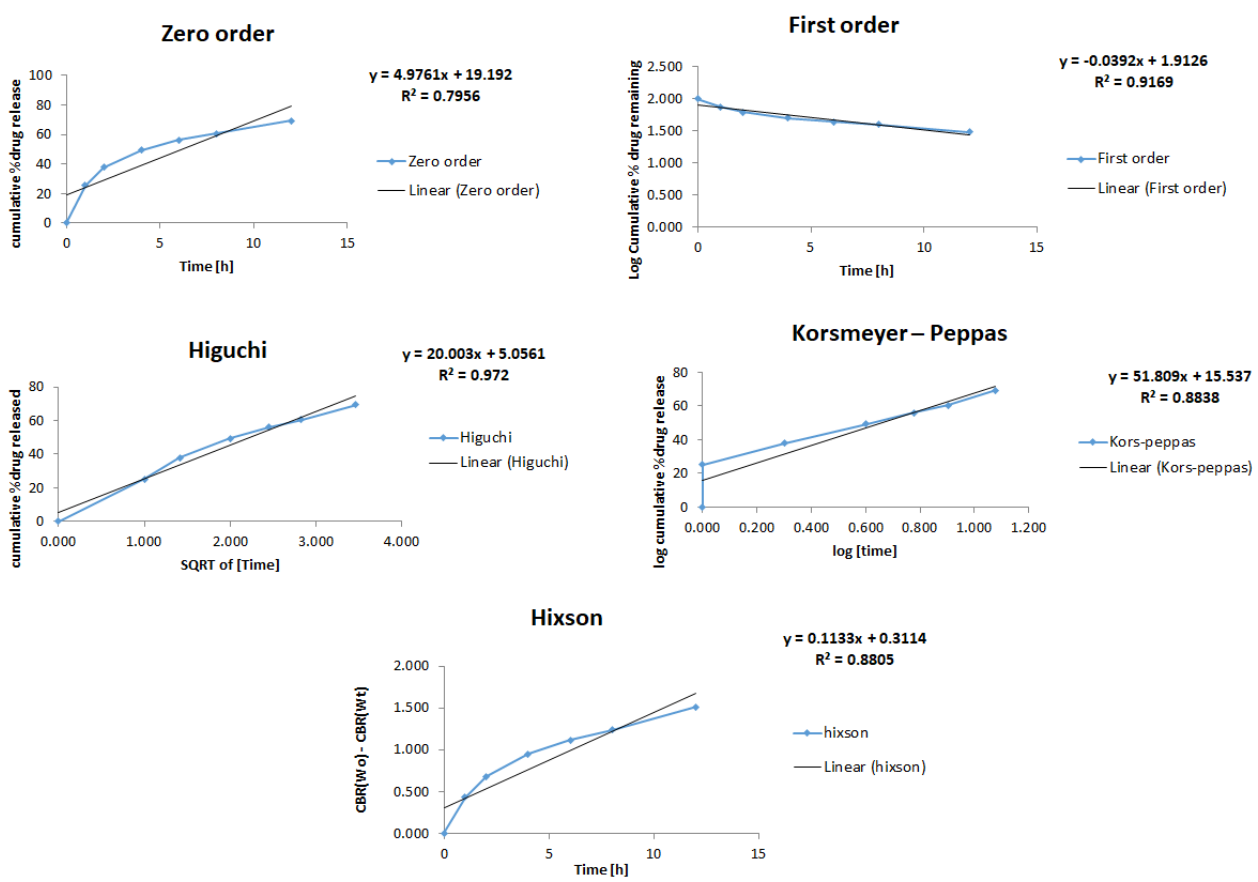
Figure 4. Release kinetics of Ps from Ps/BLs fitted to five kinetic models.